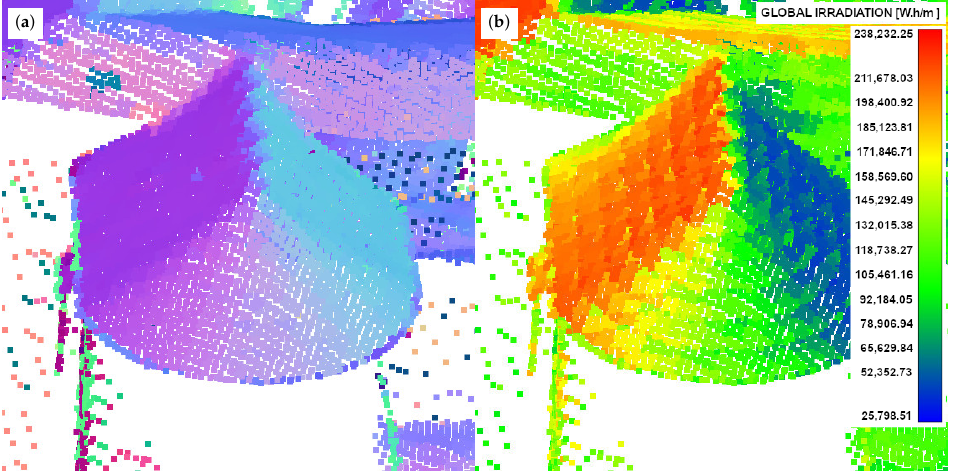
Figure 6. Detail of the tower in the Bratislava Castle ramparts (Slovakia) showing the ( a ) normal vectors visualized in RGB and ( b ) monthly sum of global solar irradiation in March. Data source: ÚGKK SR